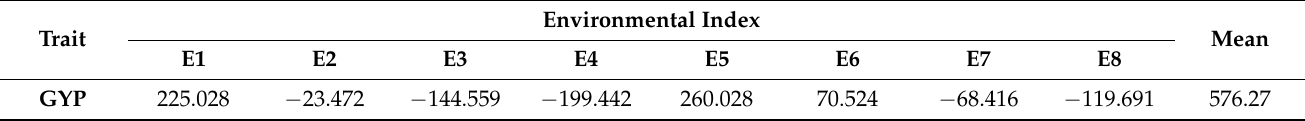
Table 7. Environmental indices for grain yield per plot across the environment in 100 wheat genotypes.